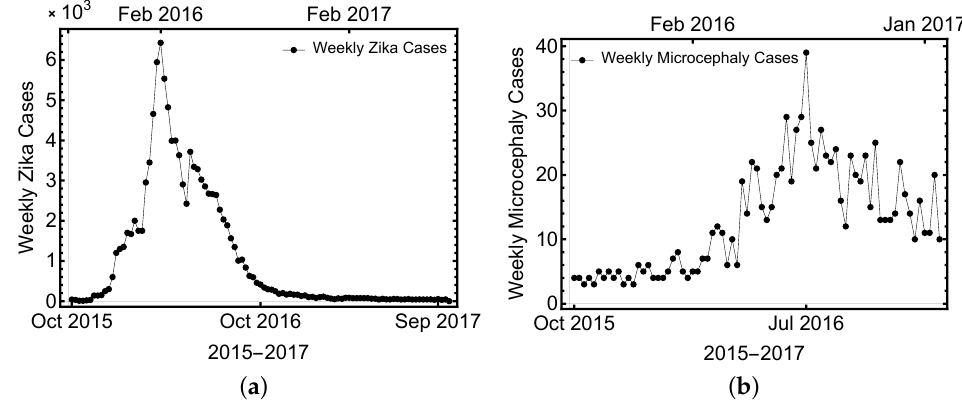
Figure 2. Colombia, weekly distribution of ZIKV and microcephaly cases, 2015–2017. ( a ) Weekly Zika cases. ( b ) Weekly microcephaly